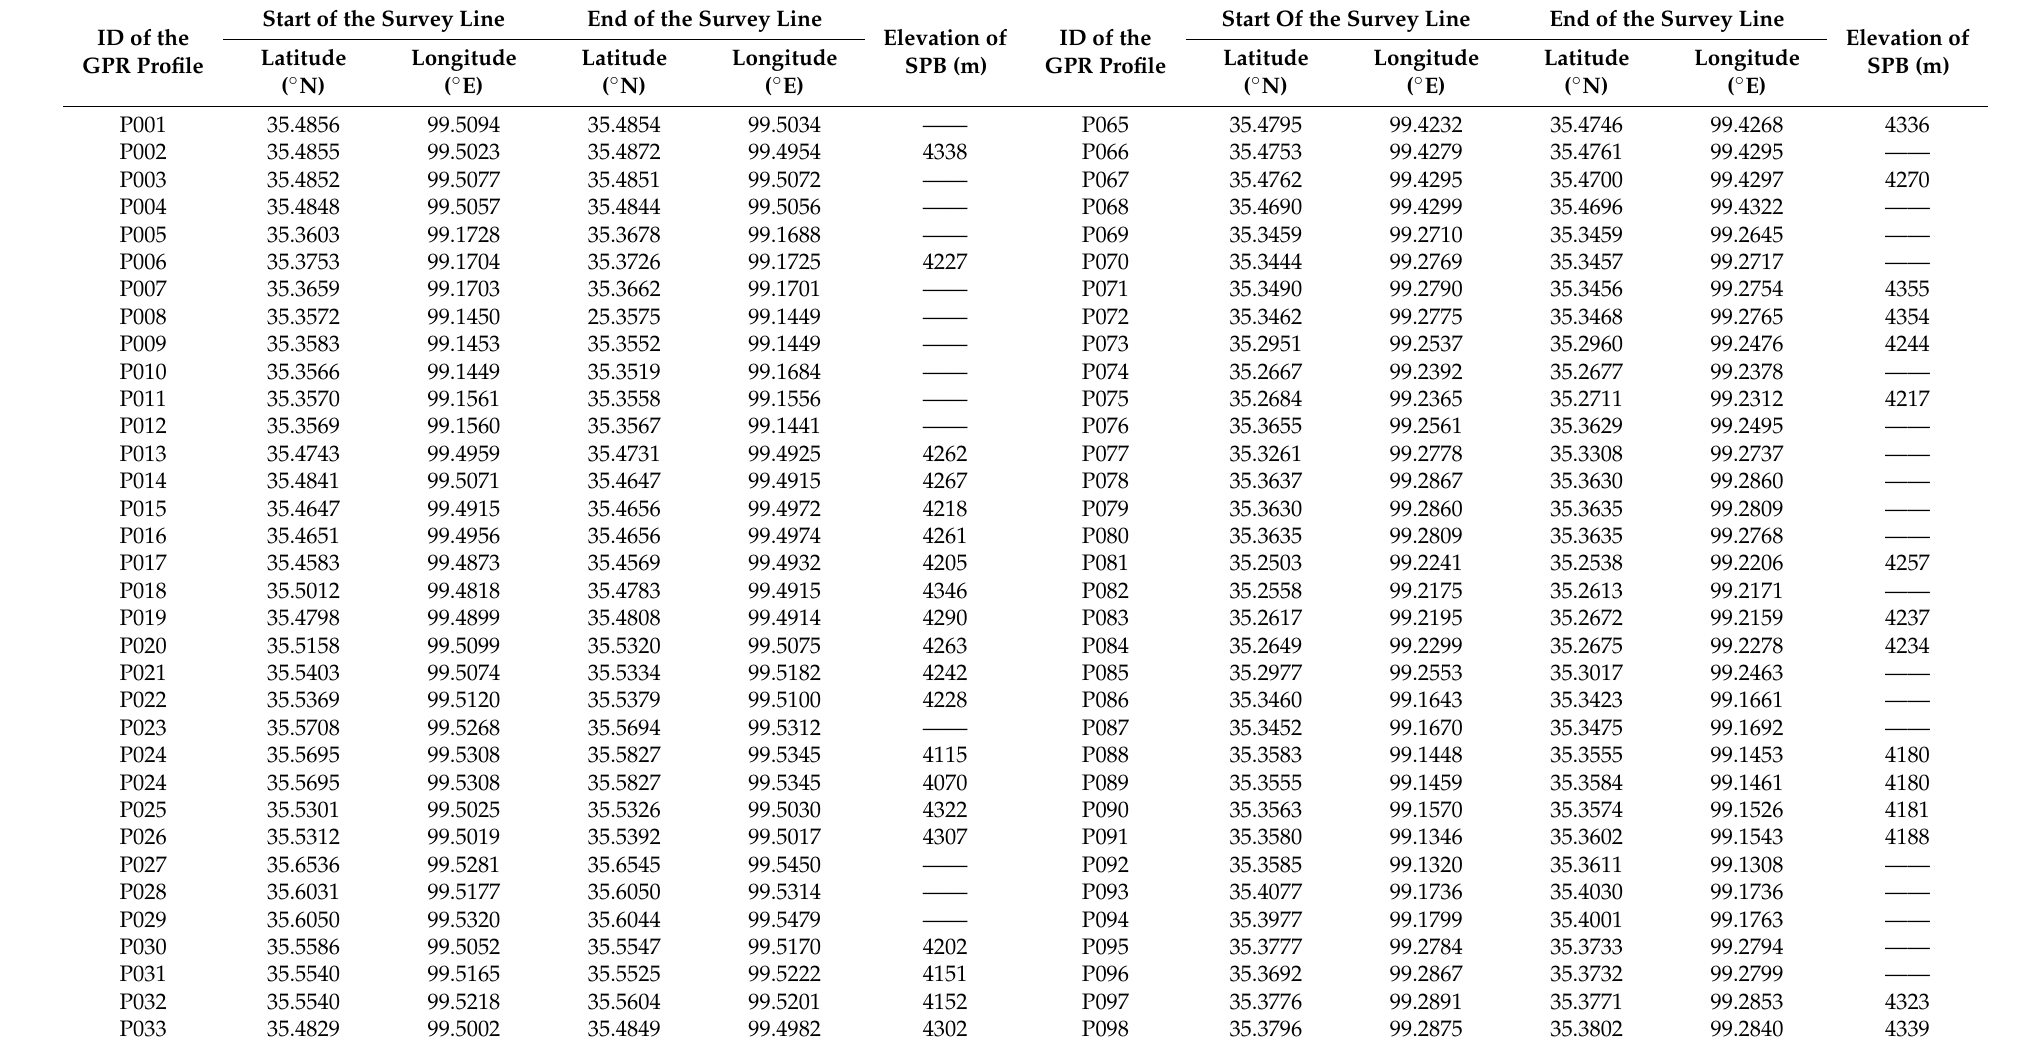
Table A1. Inventory of the GPR profiles and corresponding elevations of